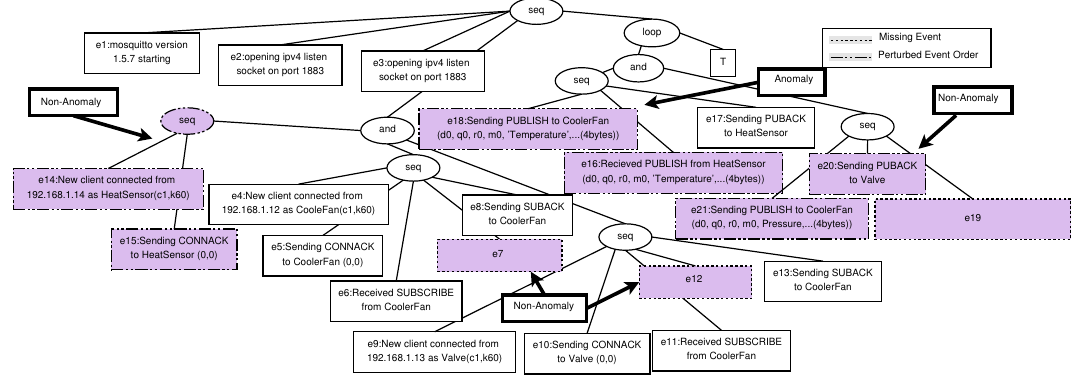
Figure 11. A process tree model L β representing observed behavior. Some missing events and perturbed event order are considered non-anomaly because the normal model L α marks them as tolerable